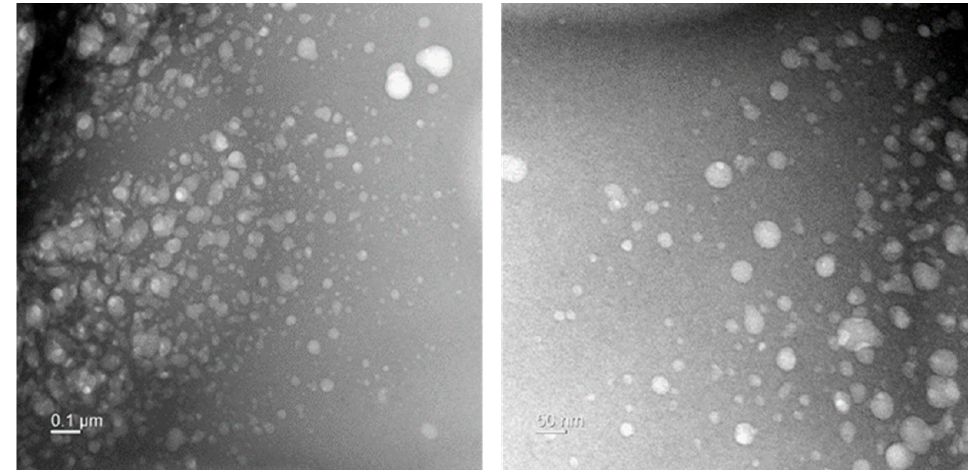
Figure 6. Transmission electron microscope image of garlic nanoparticles.